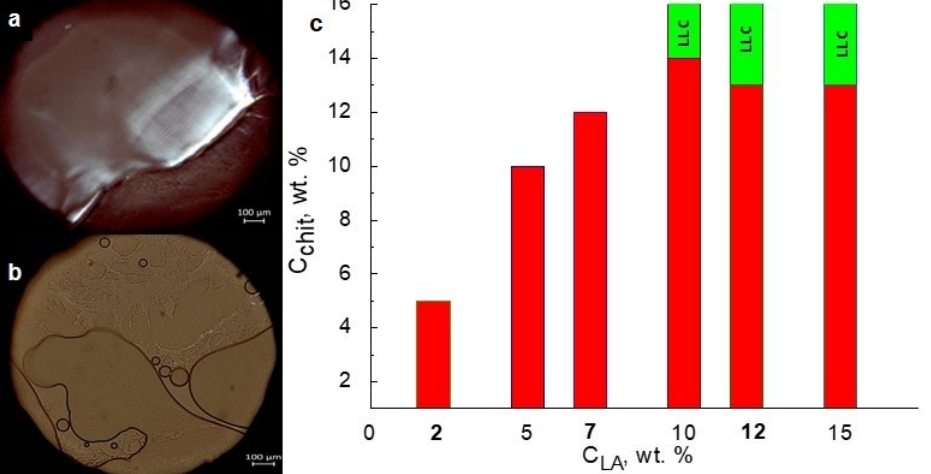
Figure 1. POM images: ( a ) Chit/LA 15/85 wt. % (C LA = 10 wt. %); ( b ) Chit/LA 8/92 wt. % (C LA = 2 wt. %); ( c ) Diagram of chitosan solubility in